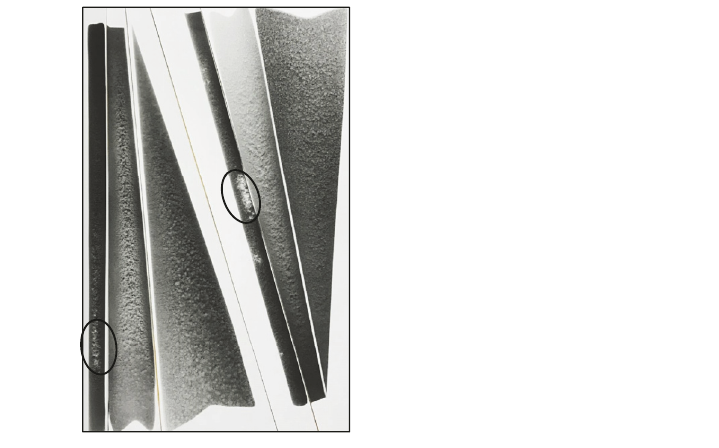
Figure 14: Porosity distribution in degassed A356 alloy castings obtained from the variable angle mold heated at 350 ∘